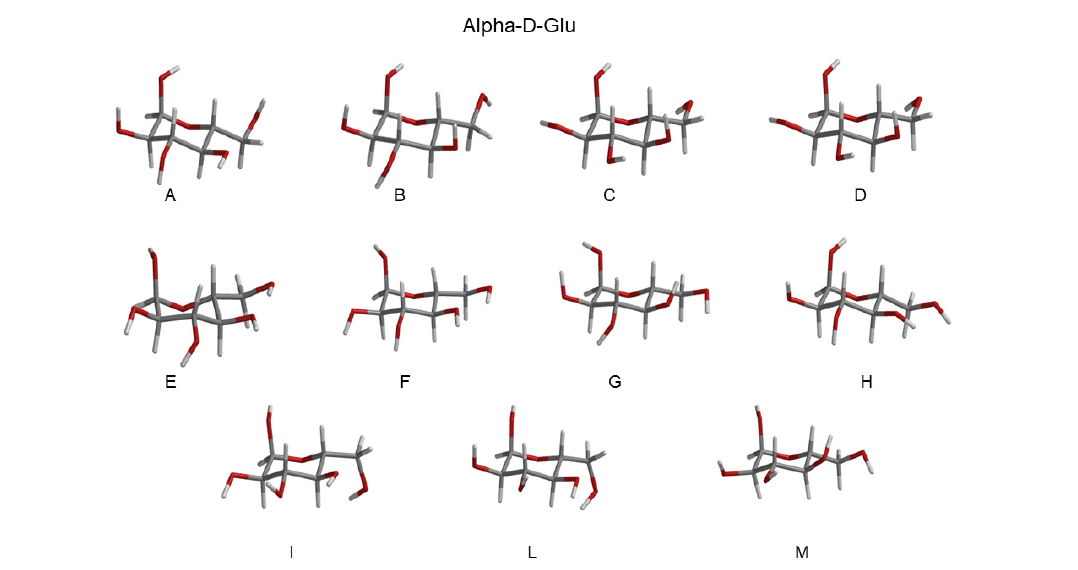
Figure 5. Schematic view of the Alpha-Glu RCs extracted from the basins, as reported in Figure 4. Additional details can be found in the Supplementary Materials.